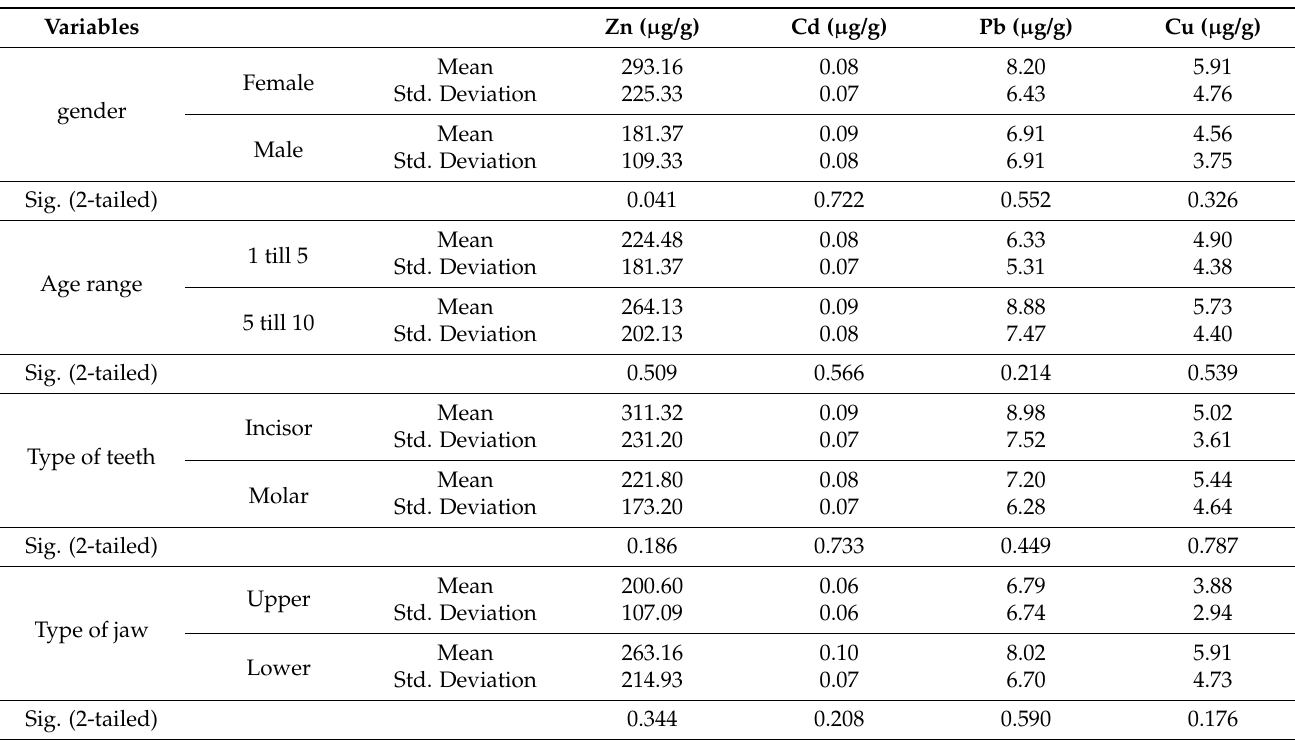
Table 4. Concentration of heavy metals among different groups of tooth type, age, tooth position, and